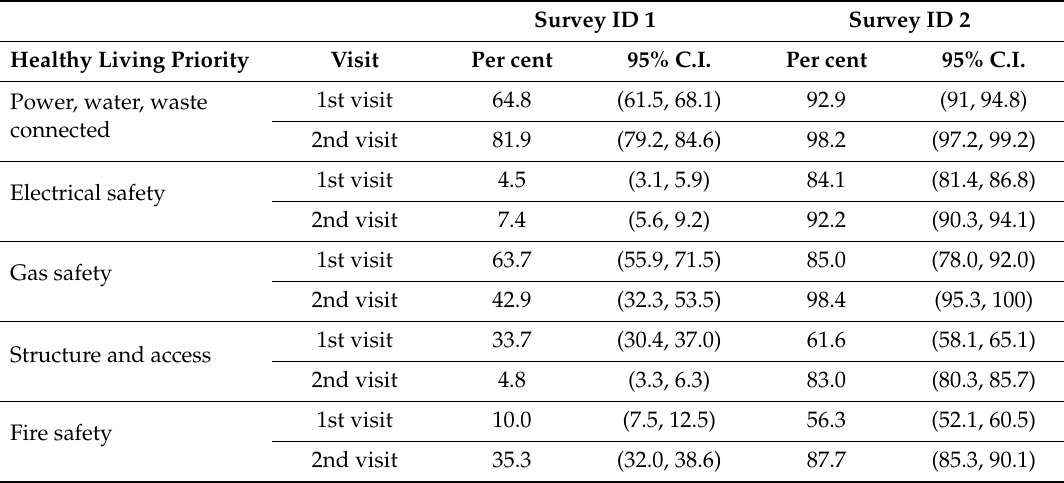
Table A7 provides the data for Figure 5: Percentage of houses with Critical Healthy Living Priorities fully met for NSW projects with repeat visits at First Project SF1 ( n = 802) and SF2 ( n = 722); and at Second Project SF1 ( n = 788) and SF2 ( n = 734) from 1998–2017 in the main text. Table A7. Percentage of houses with Critical Healthy Living Priorities fully met for NSW projects with repeat visits at First Project SF1 ( n = 802) and SF2 ( n = 722); and at Second Project SF1 ( n = 788) and SF2 ( n = 734) from